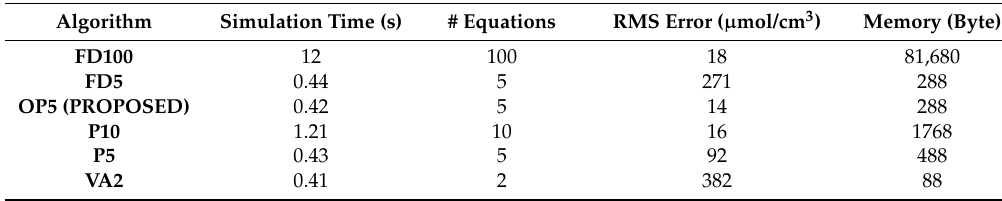
Table 2. Comparison of algorithm performance for diffusion PDE calculation.